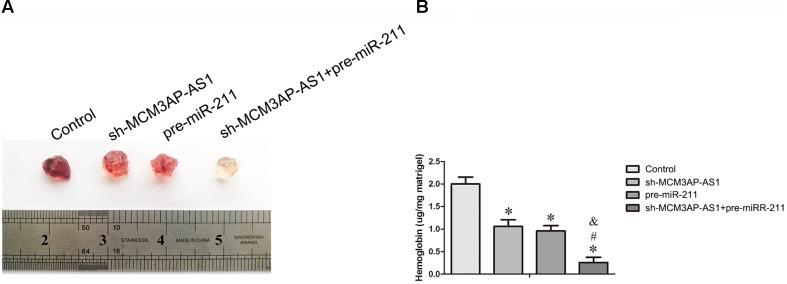
MCM3AP-AS1 knockdown combined with miR-211 overexpression inhibited GBM angiogenesis. (A) Matrigel plug assay was used to measure GBM angiogenesis. (B) The amount of hemoglobin was measured. Data are presented as mean ± SD. (n = 5, each group), ∗P < 0.05 vs. Control group; #P < 0.05 vs. sh-MCM3AP-AS1 group. &P < 0.05 vs. pre-miR-211 group.